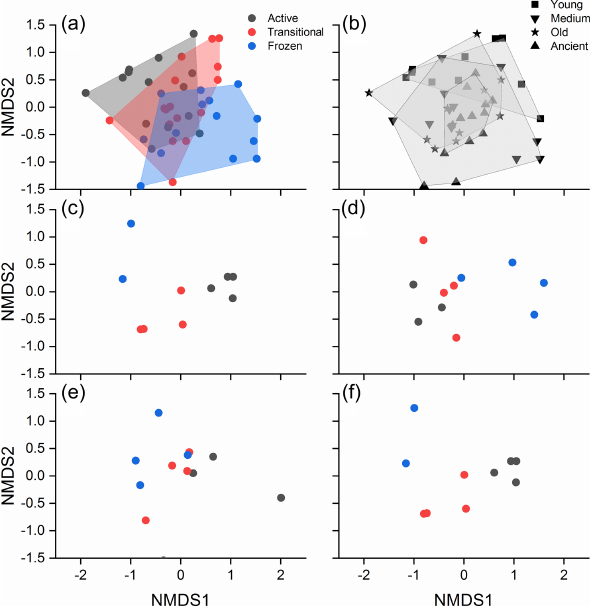
Figure 3. NMDS plots showing the bacterial community struc- ture of different thawing status (a) and permafrost age (b) . The bacterial community structure of different thawing status in the young, medium-aged, old, and ancient permafrost soils are shown in (c) – (f) . Active, transitional, and permanently frozen are permafrost thawing